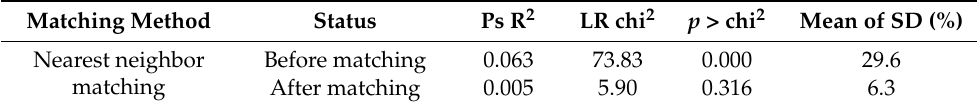
Table 3. Result of overall balance test.